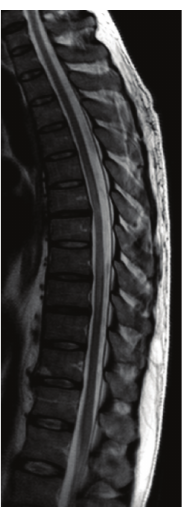
Figure 5: Sagittal T2-weighted spinal MRI 2 months later shows complete resolution of the lesion.